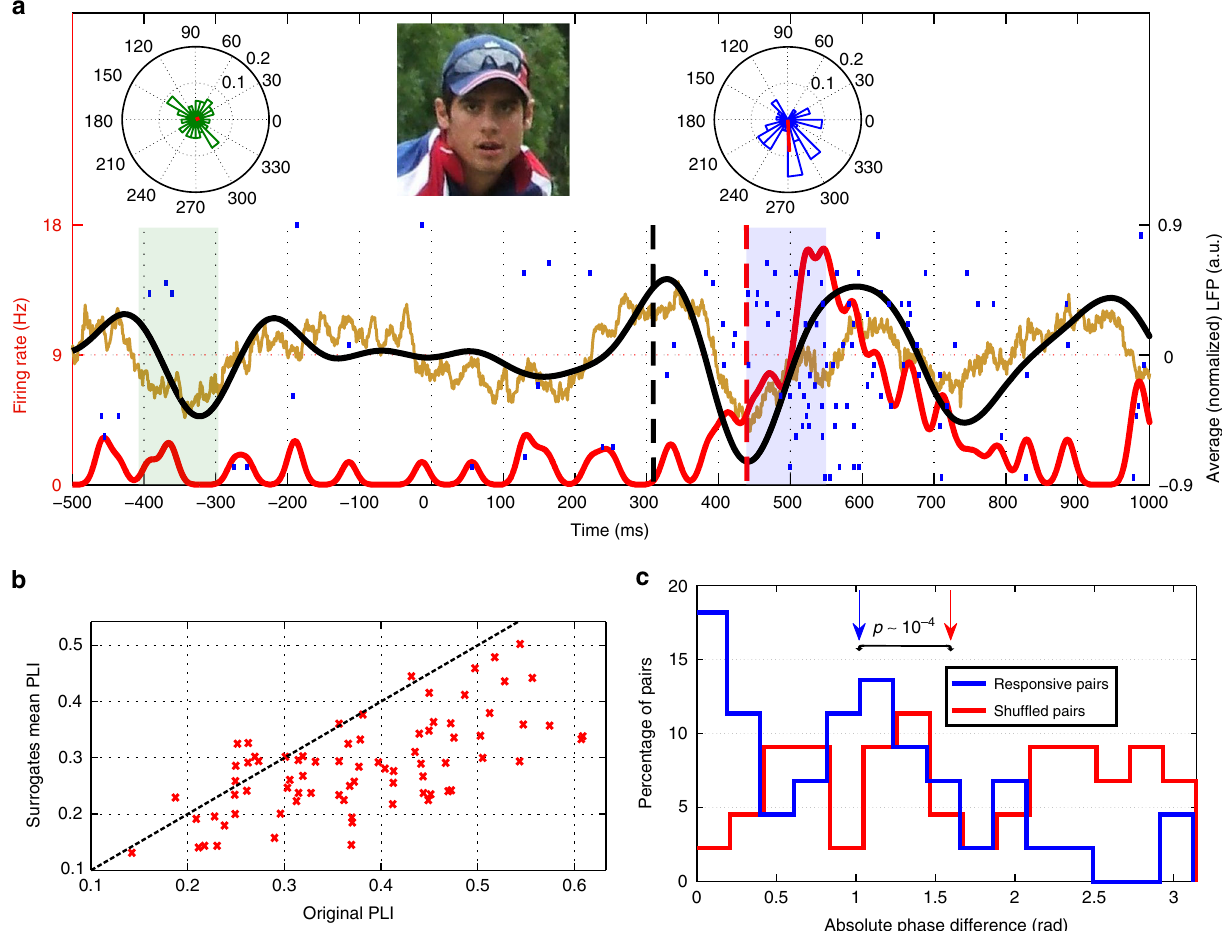
Fig. 5 Phase locking analysis for individual and multiple responses. a Exemplary unit recorded in the left hippocampus exhibiting a response to the picture of Alastair Cook, former captain of the English cricket team. Same conventions as in Fig. 3a. The spike response latency is 439 ms, with the LFP onset occurring 130 ms earlier. Circular histograms of the phase at the spike times during baseline (green, left) and response (blue, right) periods (marked with green and blue shaded areas, respectively). Red lines represent the mean phase vector. Spikes during the baseline period are not signi fi cantly phase locked (PLI = 0.05, p = 0.82), in contrast to those in the response period (PLI = 0.44, p = 1.6 × 10 − 3 ). Due to copyright issues, the image presented here (cropped from “ Alastair cook bowl ” by Blnguyen, licensed under CC BY-SA 3.0) is similar to the one actually presented to the subject. b PLI for the signi fi cant phase- locked responses (actual vs. mean of the surrogate distribution). The mean shuf fl ed values were signi fi cantly smaller than the original ones ( n = 82, one- sided paired sign test, p ~ 10 − 11 ), showing a relation between the spike times and the instantaneous LFP phases at the single trial level. c Distribution of mean phase difference for the responsive and surrogate pairs. The difference in the response-eliciting pairs was signi fi cantly smaller than the one on